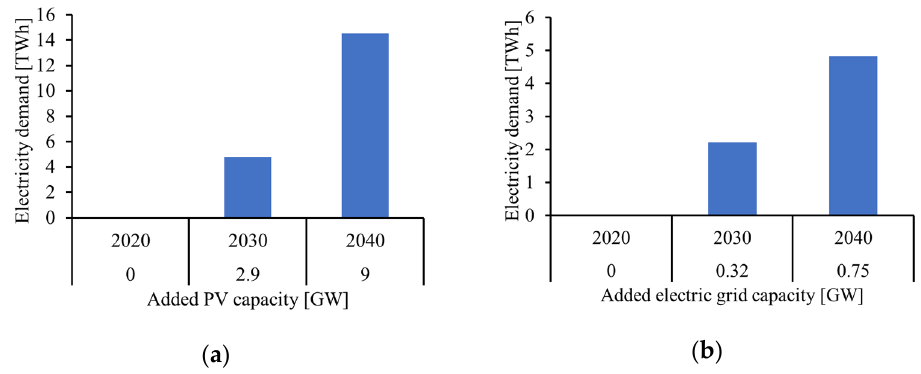
Figure 9. Yearly EVs’ electricity demand with ( a ) added PV (daytime) and ( b ) added conventional power plant (nighttime) capacities.